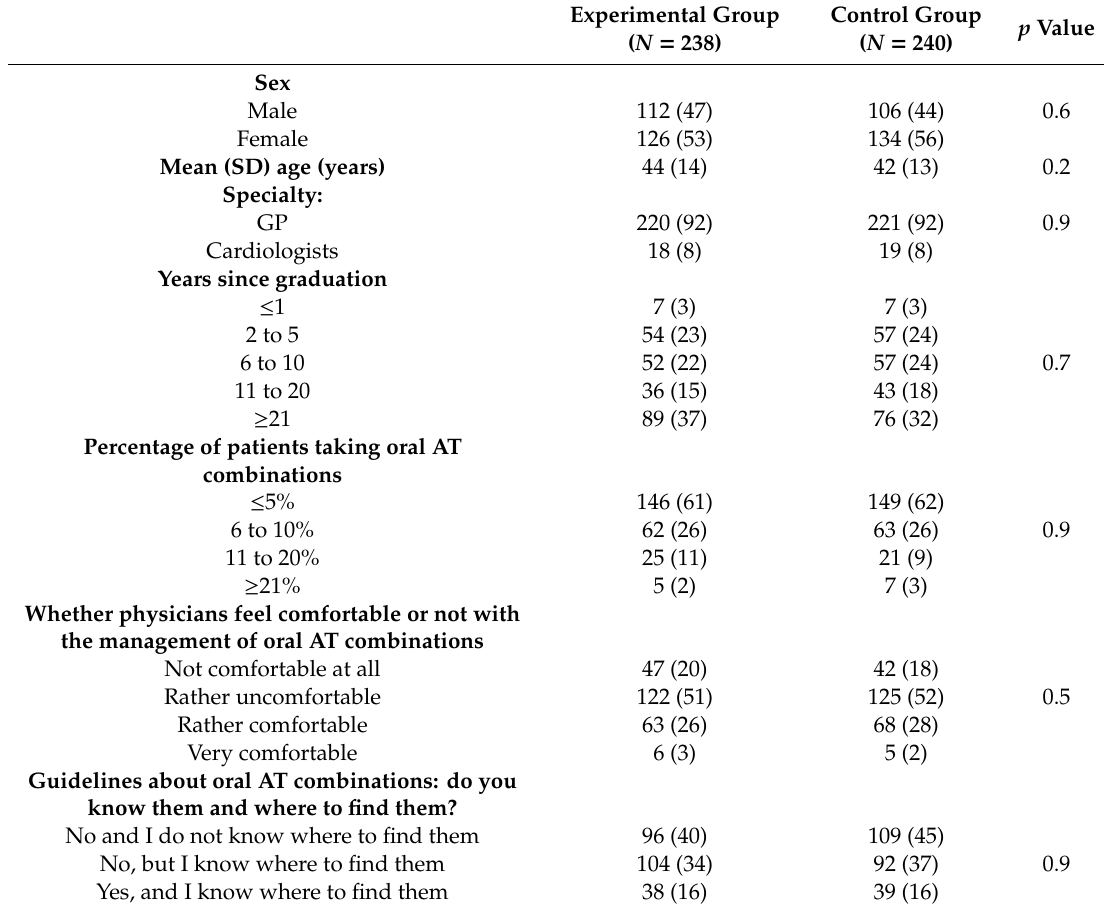
Table 1. Baseline characteristics of randomized physicians. Values are numbers (percentages) unless stated